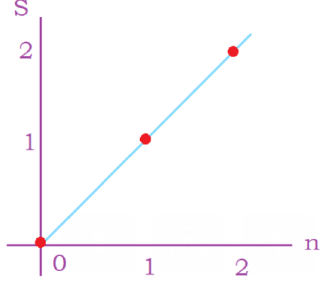
Figure 17 . The entropy S at T = ∞ .